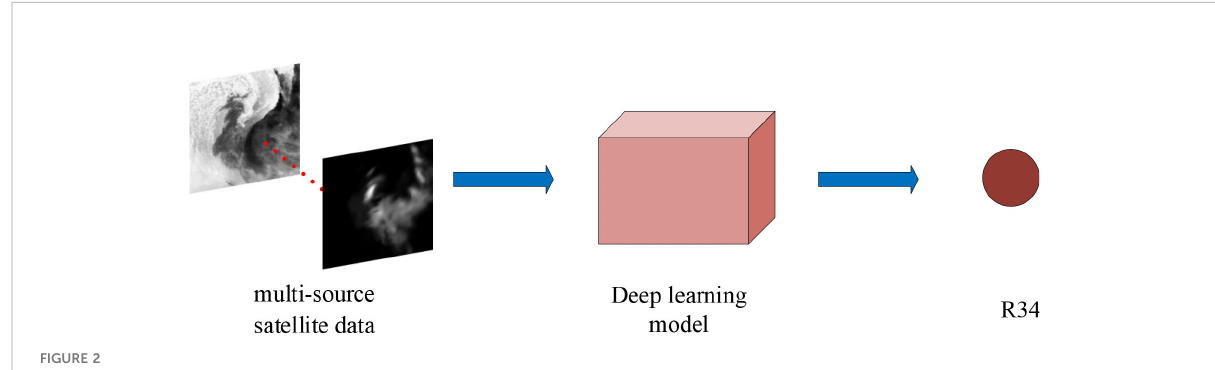
FIGURE 2 Problem de fi nition